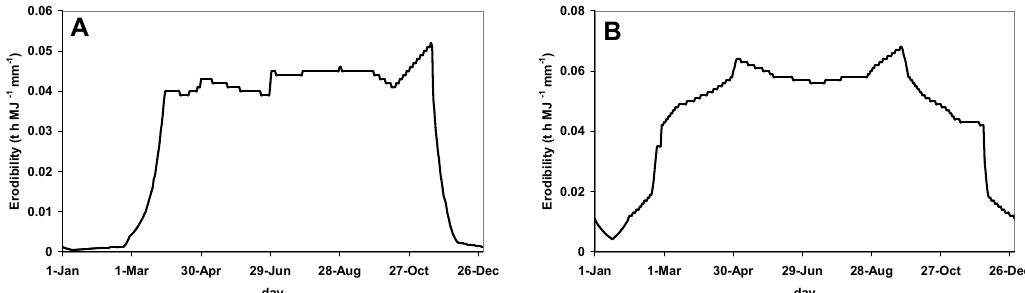
Figure 1. Average daily soil erodibility values for ( A ) Caribou gravely loam at Presque Isle, Maine (ME), and ( B ) Shelby loam at Bethany, Missouri (MO) used in the Revised Universal Soil Loss Equation, Version 2 (RUSLE2) (source: Kinnell [18]).